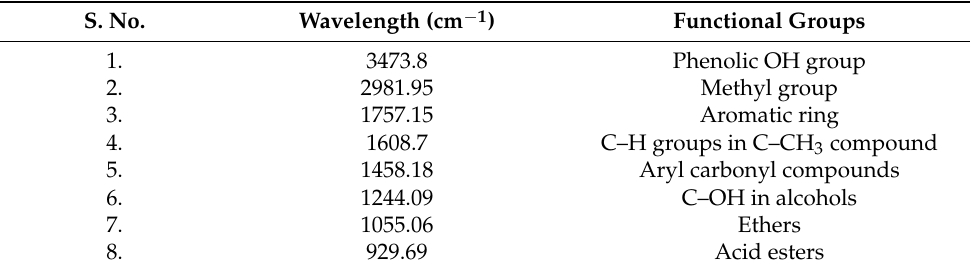
Table 2. Functional groups of purified DAPG by FT-IR analysis.